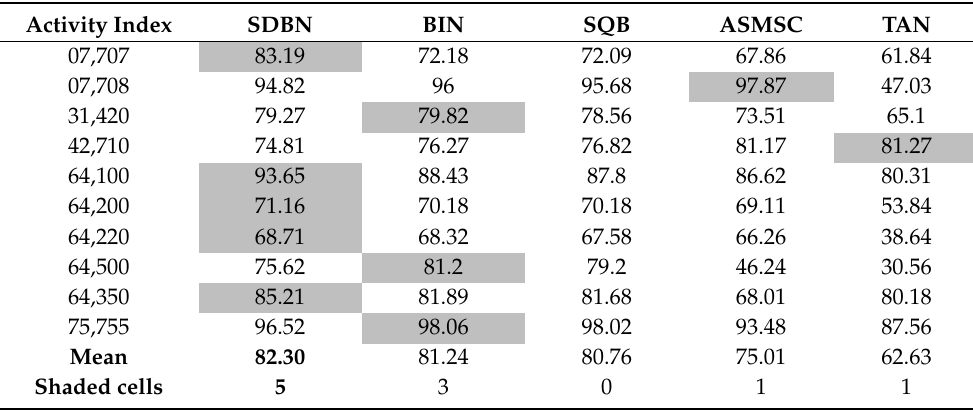
Table 6. Retrieval results of top 1% for MDDR-DS2